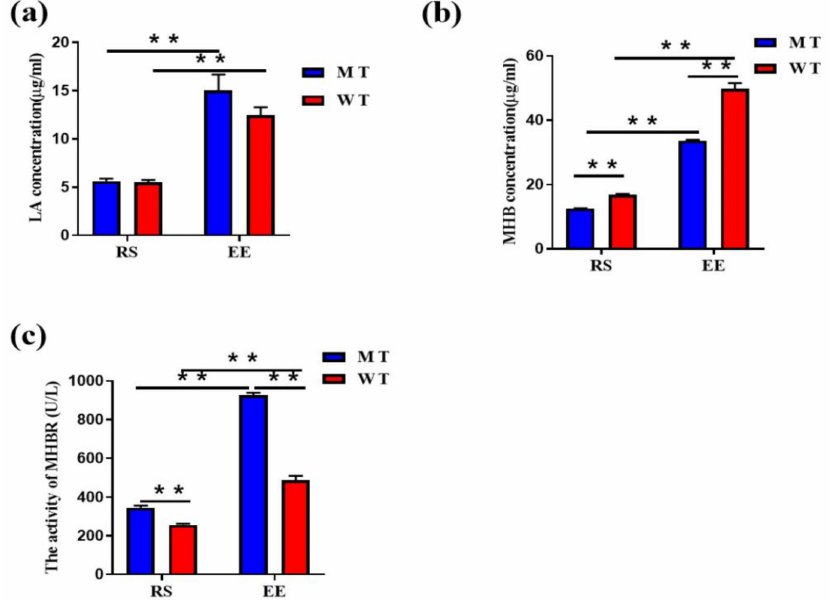
Figure 2. Effect of exhaustive exercise on MSTN knockout cattle. ( a ) Lactic acid concentration in the cattle plasma; ( b ) Levels of MHB; ( c ) The activity of MHBR. MT: MSTN knockout cattle group;WT: Wild type cattle group; RS: Resting state; EE: Exhaustive exercise state; Data presented are means ± SD. One-way ANOVA with post hoc LSD multiple-comparison test, ** p <